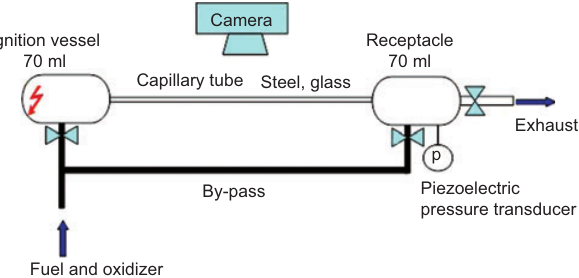
Figure 2 Schematic diagram of the ‘ capillary setup ’